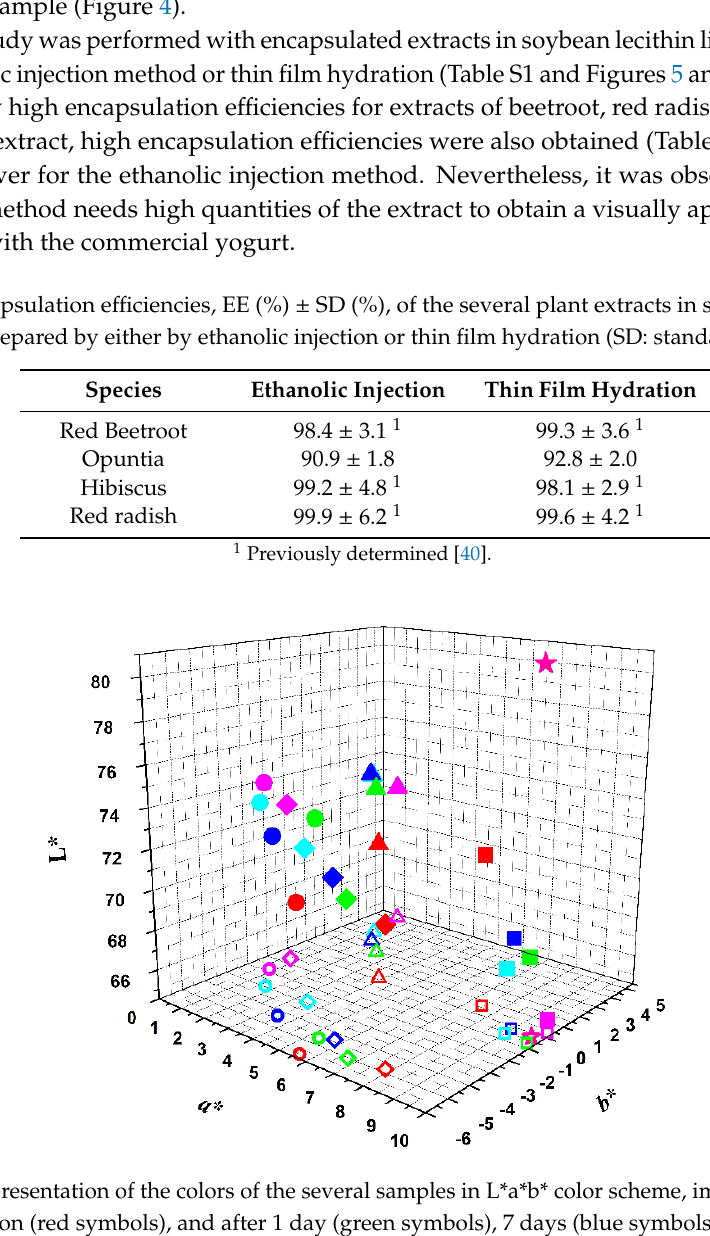
Figure 4. Representation of the colors of the several samples in L*a*b* color scheme, immediately after extract addition (red symbols), and after 1 day (green symbols), 7 days (blue symbols), 14 days (cyan symbols) and 21 days (magenta symbols) of storage at 4 ◦ C. Projection in a*,b* plane: open symbols. : red beetroot;